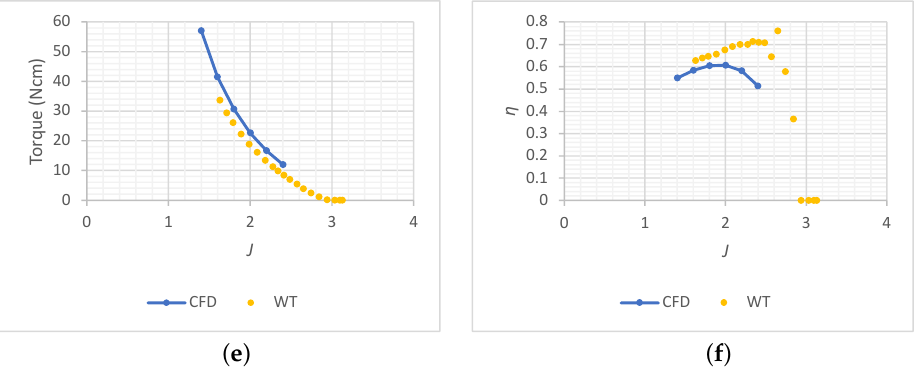
Figure 11. Wind tunnel (WT) data, comparison with CFD results at V ∞ = 35 m/s: ( a ) thrust; ( b ) thrust coefficient; ( c ) power; ( d ) power coefficient; ( e ) torque; ( f ) propeller